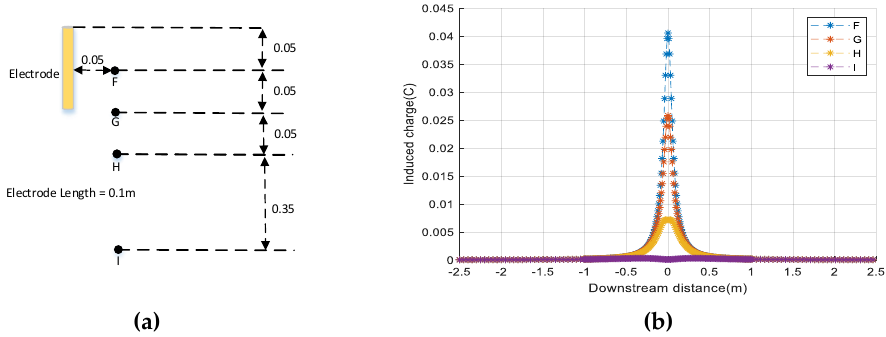
Figure 8. Locations of point charges F, G, H, I in the pipeline: ( a ) Position of the point charge and electrode; and ( b ) amount of the induced charge on the electrode as distance changes.